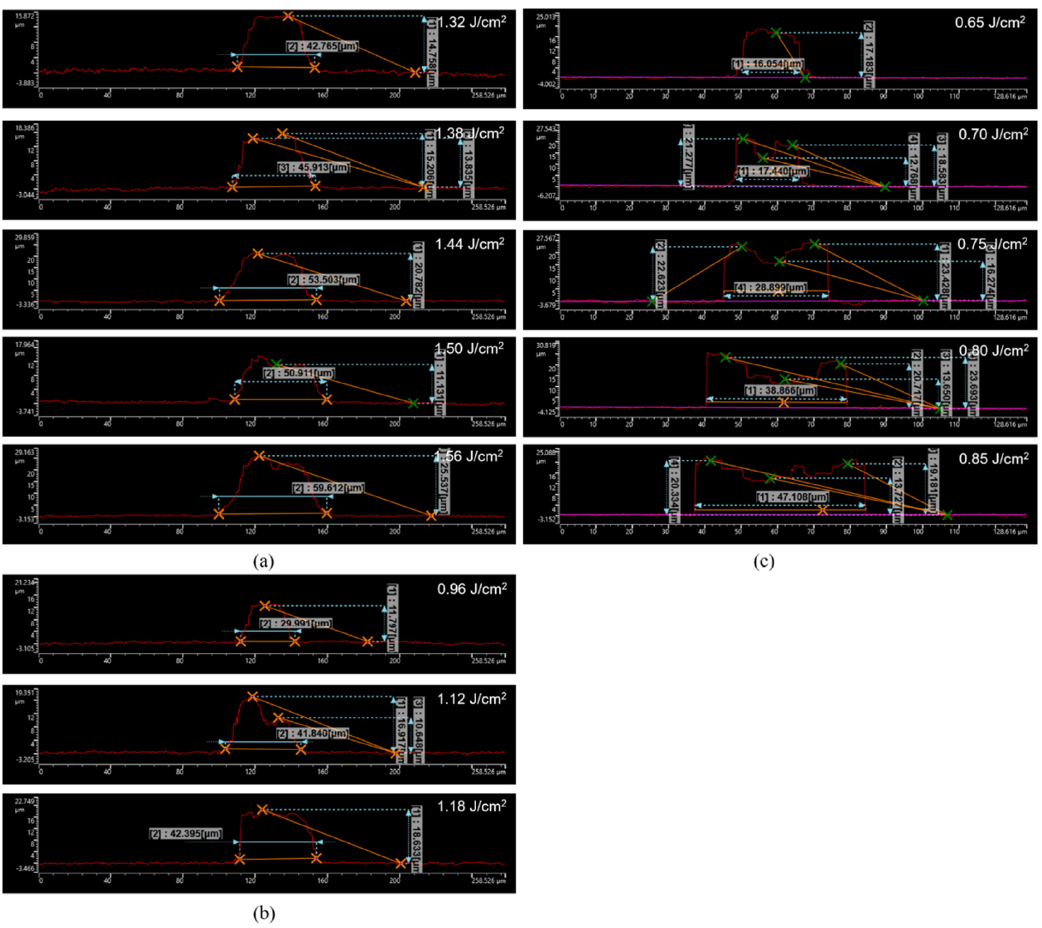
Figure 6. Cross-sectional profiles of the formed lines under different laser fluences and processing speeds obtained by LSCM. ( a ) 1.32–1.56 J/cm 2 , 5000 mm/s, ( b ) 0.96–1.18 J/cm 2 , 2500 mm/s, ( c ) 0.65–0.85 J/cm 2 , 1000 mm/s.